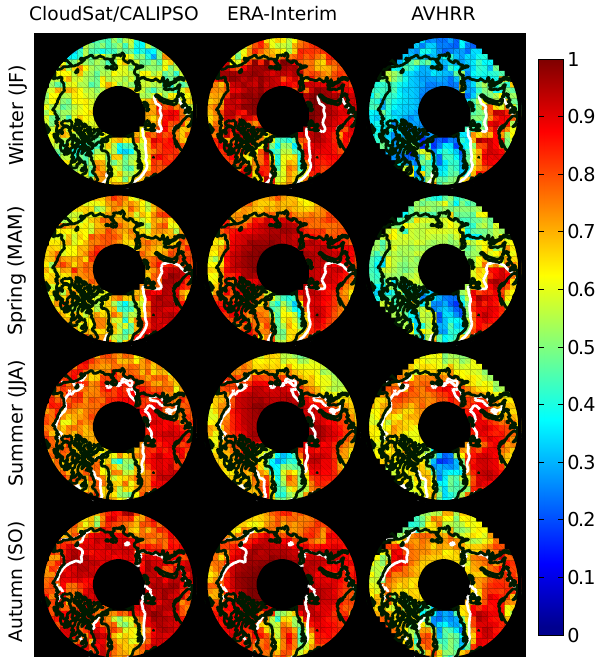
Fig. 3. Geographical distribution of seasonal mean total cloud fraction based on the merged CloudSat/CALIPSO data, for ERA- Interim Reanalysis data and for CM-SAF for 2009. Values for win- ter are averaged over January and February and autumn only for September and October. The white line indicates the sea ice margin in the four seasons as derived from SSM/I satellite